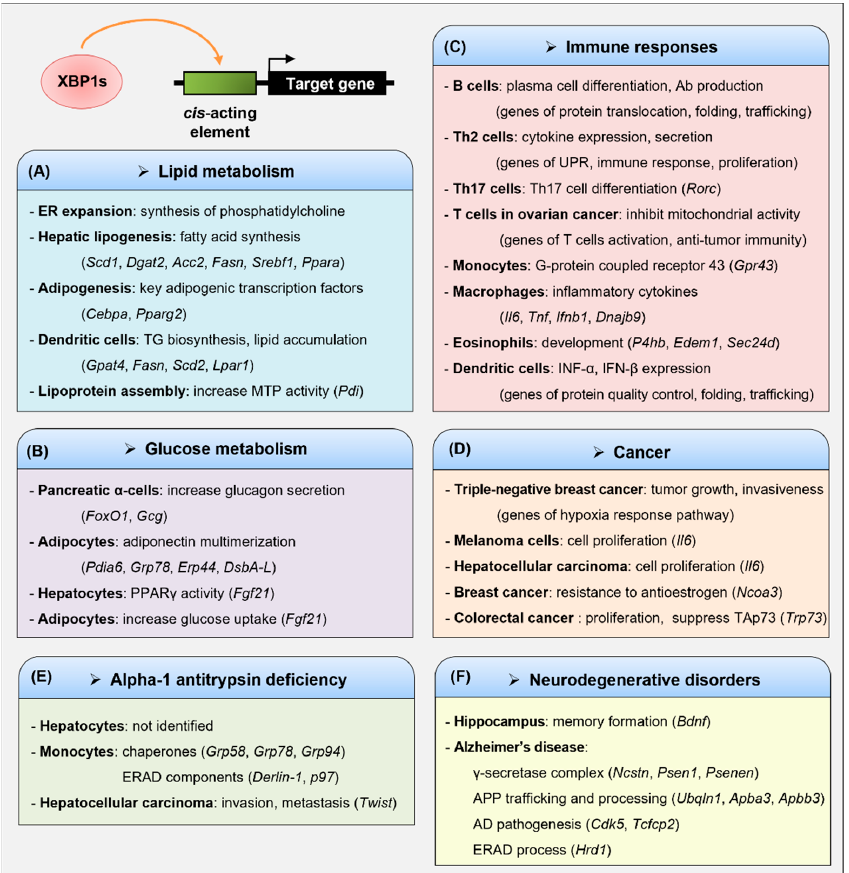
Figure 3. Transcriptional regulation of target genes by XBP1s. XBP1s regulates the transcription of various target genes that constitute unique subsets depending on the specific stimuli and cell types.